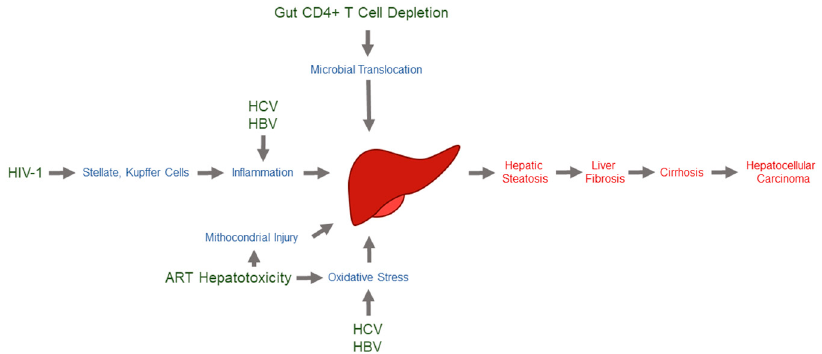
Figure 2. Most relevant mechanisms of liver injury in people living with HIV-1. Mechanisms by which different disease entities may cause hepatic injury and fibrosis include oxidative stress, mi- tochondrial injury, lipotoxicity, immune-mediated injury, cytotoxicity, toxic metabolite accumula- tion, gut microbial translocation, systemic inflammation, senescence, and nodular regenerative hy- perplasia. HIV-1 may use any number of these mechanisms to exert an effect on the liver [19]. After the success of highly active antiretroviral therapy (ART), chronic, noninfectious